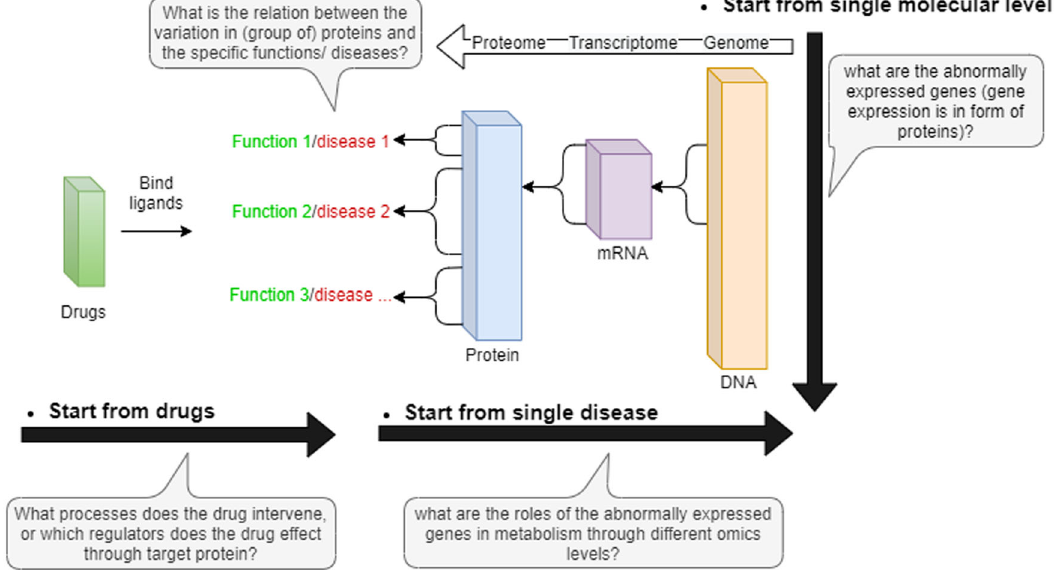
Fig. 2 Analyses of disease and drug effect through single and multiple layers of omics data. Systemic view enables scientists to establish disease models from a higher hierarchic level by multi-layer data integration. Through vertical analysis within single layers, the disease-related molecules are identi fi ed by abnormal gene expression values. Through horizontal analysis with different layers, the interactive information are used to track diseases or drug effects throughout the entire biological